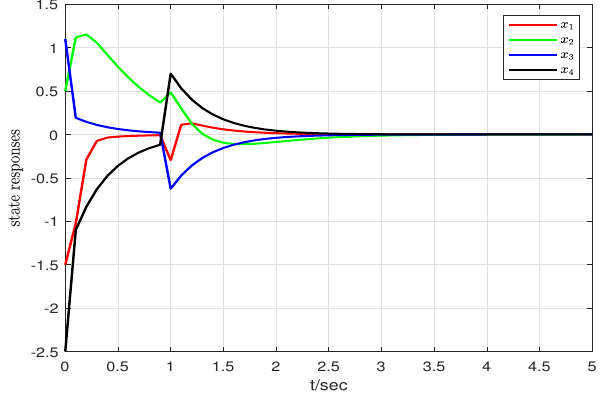
Figure 7. Stability behavior for FO condition α = 0.85 in Example